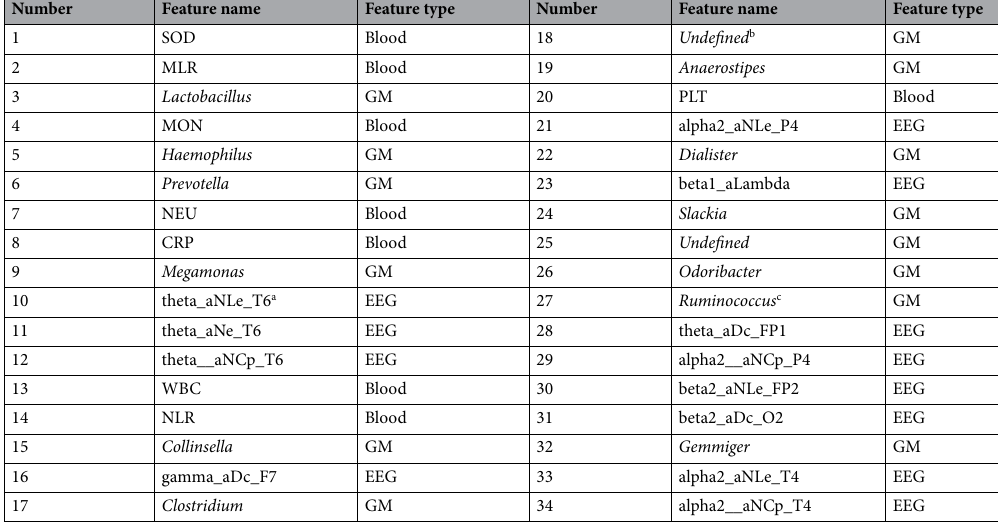
Table 3. Top 34 features (5%) showing the most discriminative biomarkers for multi-biological predictions. The top 34 features are listed in the descending order of their weights. GM gut microbiota, EEG electroencephalogram, SOD superoxide dismutase, MLR monocyte–lymphocyte ratio, MON monocyte, NEU neutrophil, CRP C-reactive protein, WBC white blood cell, NLR neutrophil–lymphocyte ratio, PLT platelet, aNLe nodal local efficiency, aNe nodal efficiency, aNCp nodal clustering coefficient, aDc degree centrality. a The EEG features are represented as a_b_c, where a represents the frequency band, b represents brain network attributes, and c represents the electrode channel. b Undefined Lachnospiraceae. c Undefined Ruminococcaceae.